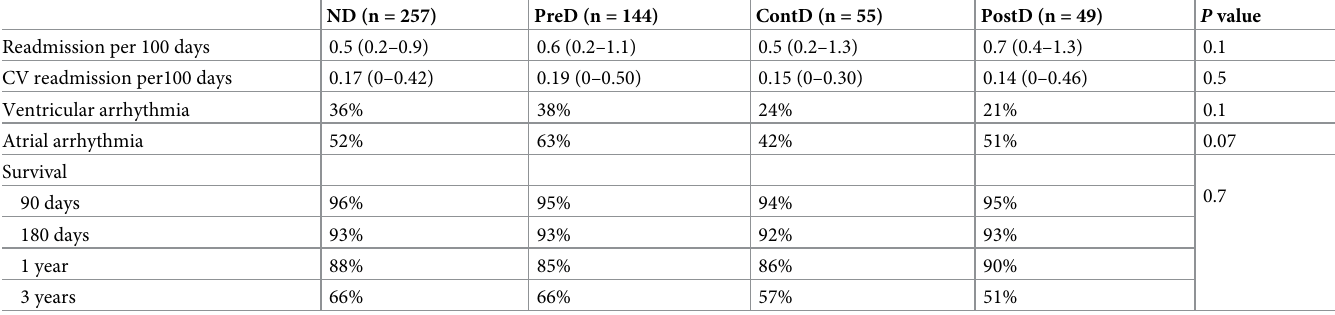
Table 2. Post VAD outcomes and survival by digoxin